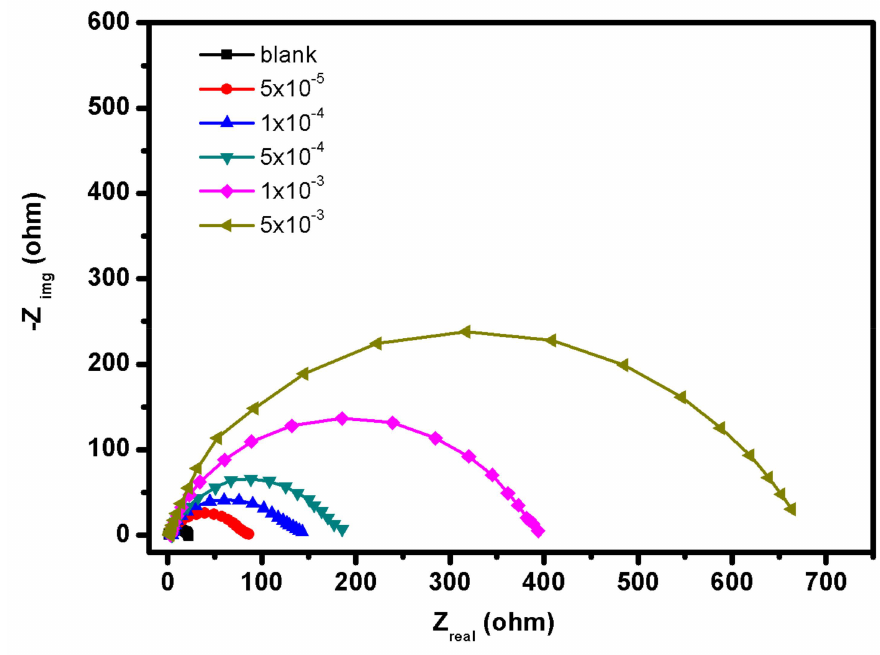
Figure 3. Nyquist plots for mild steel in presence of 1.0 M HCl alone and containing different concentrations of BBMImIM ionic liquid at 25 ◦ C.